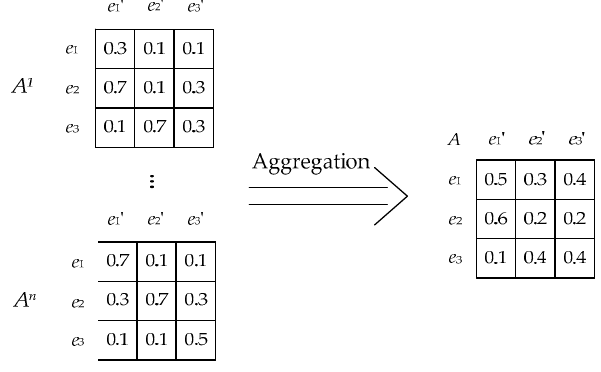
Figure 2. Aggregation of alignments obtained by basic matchers.